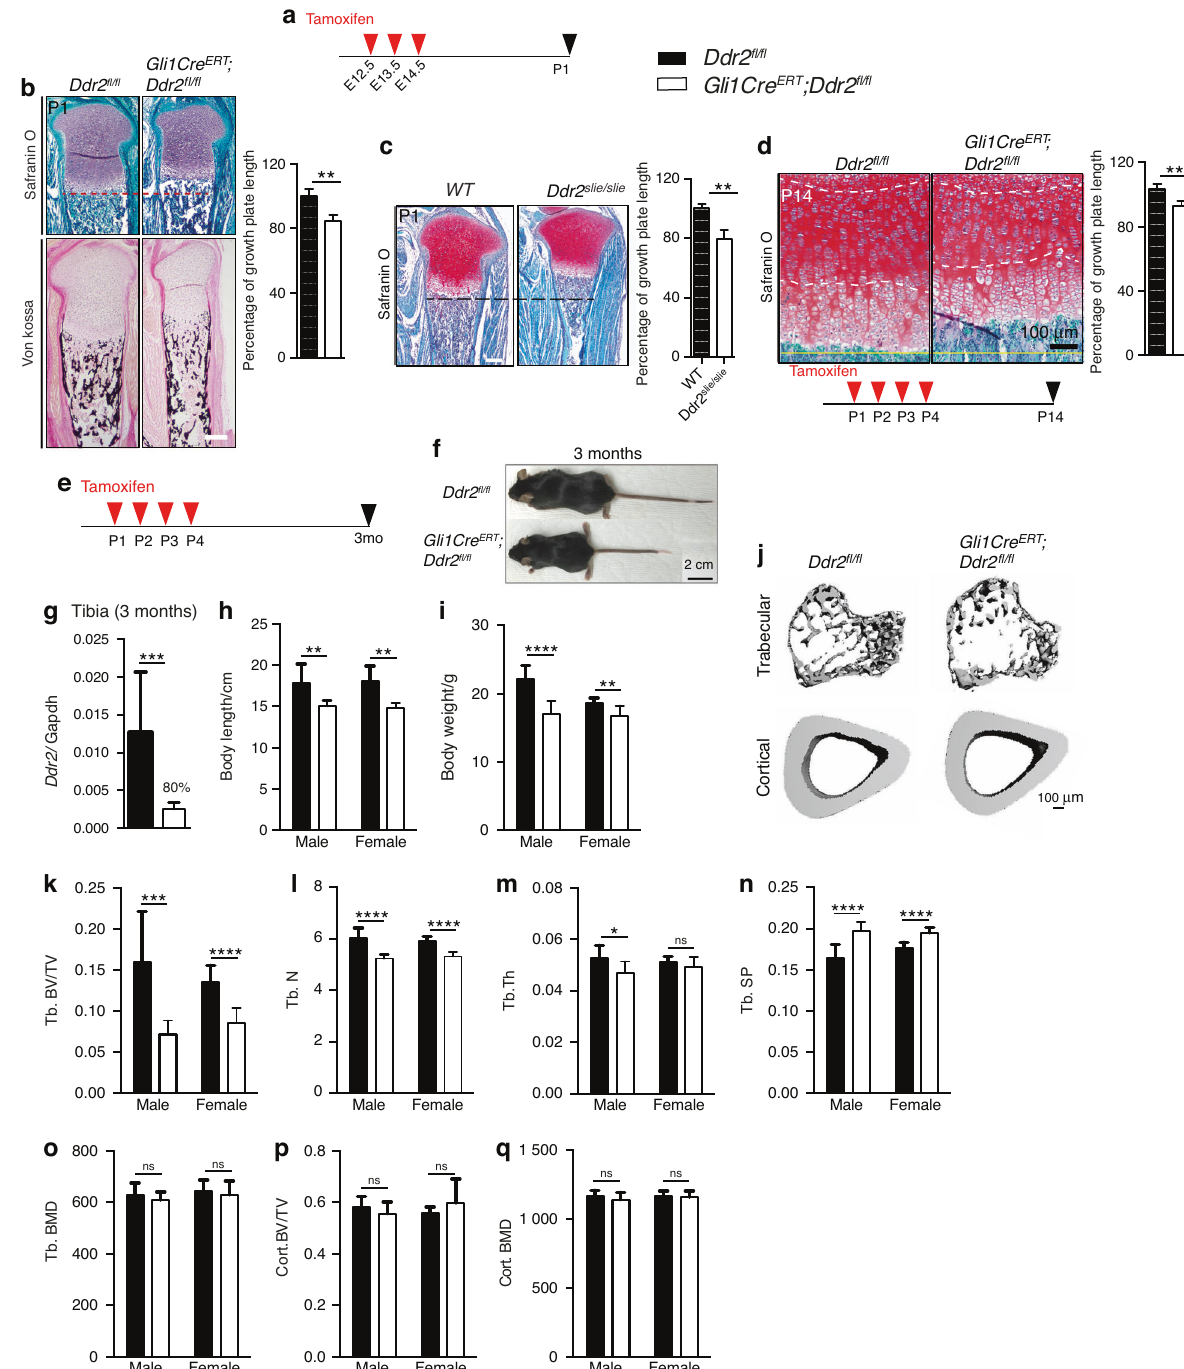
Female0.000.050.100.150.20 BV . T b Fig. 4 Requirement for Ddr2 in Gli1 -positive chondro-osteoprogenitors. a Experimental protocol for embryonic study ( b ). b Safranin O and von Kossa staining of tibia from Ddr2 fl / fl ( n = 3) and Gli1-Cre ERT ;Ddr2 fl / fl ( n = 4) newborns. von Kossa staining (lower panel) shows no evident difference in mineralization (black staining). Scale bar: 200 μ m. Right; quanti fi cation of growth plate length. c Safranin O staining of proximal tibia growth plates from WT and Ddr2 Slie/Slie newborns. The dotted line indicates the growth plate lengths of mutant in relation to WT. Scale bar: 200 μ m. Right; quanti fi cation of growth plate length ( n = 3). d Safranin O staining and quanti fi cation (right) showing reduced growth plate lengths in mutant mice at 2 weeks of age ( n = 3), experimental protocol at the bottom. Scale bar: 100 μ m. e Experimental protocol for adult study. f Gross phenotype of 3 month-old Ddr2 fl / fl and Gli1-Cre ERT ;Ddr2 fl / fl littermates. Gli1-Cre ERT ;Ddr2 fl / fl mice have skeletal dwar fi sm ( n = 20, 10 mice/sex). Scale bar, 2 cm. g Gene expression analysis of Ddr2 from whole 3 month-old tibiae to con fi rm knockout ef fi ciency ( n = 6 mice). h , i Body length (cm) and weight (g) measurements ( n = 20, 10 mice/sex). j 3D micro-computed tomography (microCT) models of the tibial metaphysis and cortical mid-shaft in 3 month-old Ddr2 fl / fl and Gli1-Cre ERT ;Ddr2 fl / fl mice. Scale bar 100 µm. k – o Quanti fi cation of trabecular bone volume fraction (Trab. BV/TV), trabecular number (Tb.N), trabecular thickness (Tb.Th), trabecular spacing (Tb.Sp), and bone mineral density (Trab. BMD). ( n = 20, 10 mice/sex). p , q Quanti fi cation of cortical bone volume fraction (Cort. BV/TV), and bone mineral density (Cort. BMD). Statistics: Data are expressed as mean ± SD. Unpaired t-test, * P < 0.05, ** P < 0.01; *** P < 0.001; **** P < 0.000 1; ns, not signi fi